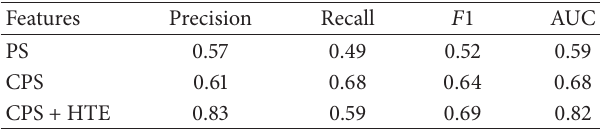
Table 1: Performances of logistic regression models trained on different features.